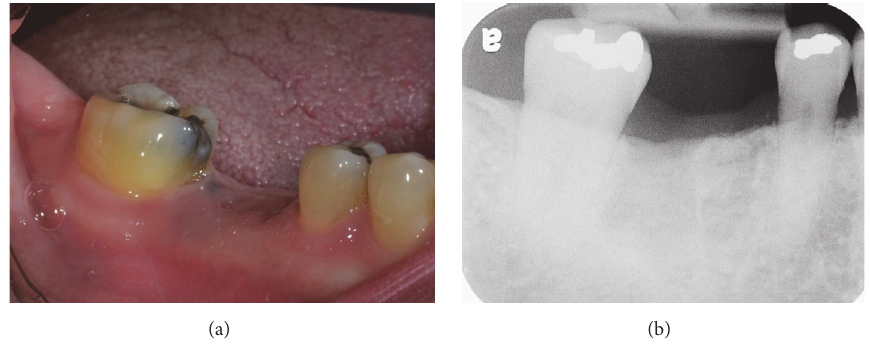
Figure 2: Preoperative views: (a) intraoral; (b) periapical radiograph.